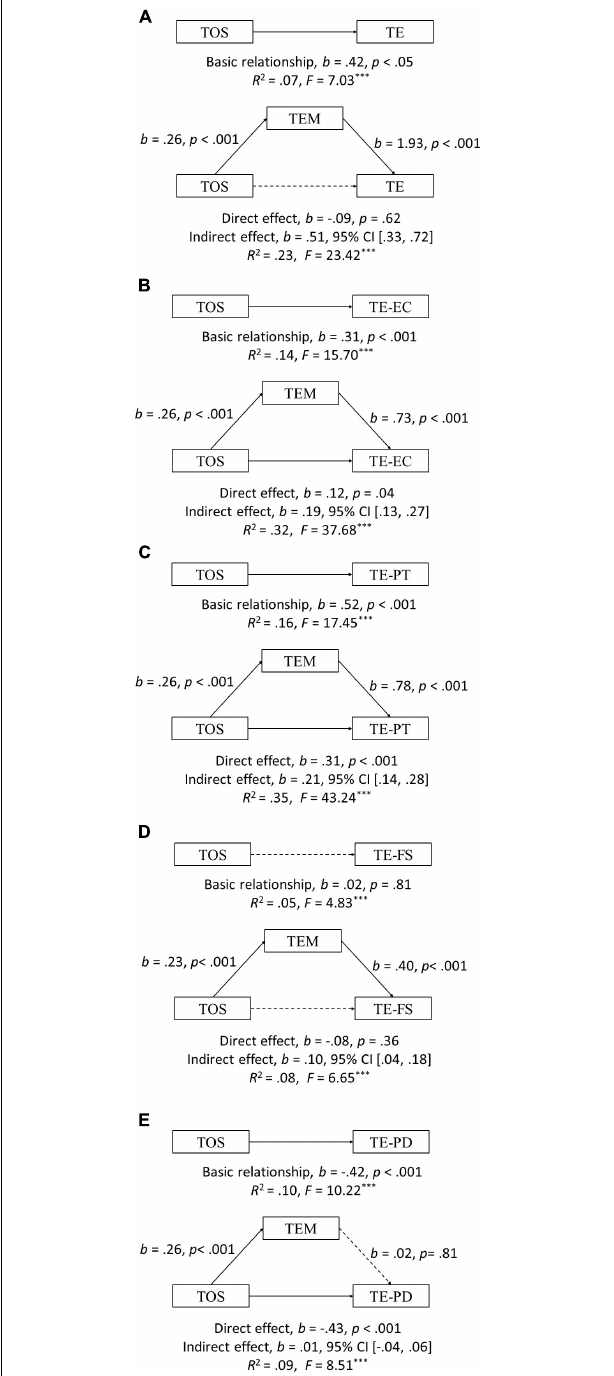
FIGURE 2 | Models of teacher empathic motivation (TEM) as a mediator variable for the relationship between the theories of student development (TOS), teacher empathy (TE; A ), empathic concern of teacher empathy (TE-EC; B ), perspective taking of teacher empathy (TE-PT; C ), fantasy of teacher empathy (TE-FS; D ) and personal distress of teacher empathy (TE-PD, E ). Non-standardized coefficients are reported. The solid lines represent significant coefficients, and the dashed line means insignificant effects. *** p <